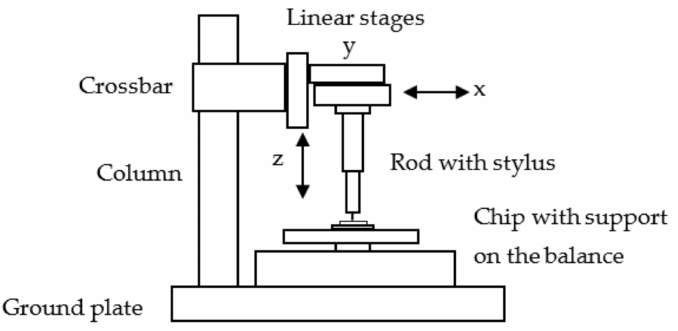
Figure 2. Scheme of instrument 1 for the measurement of the force–bending